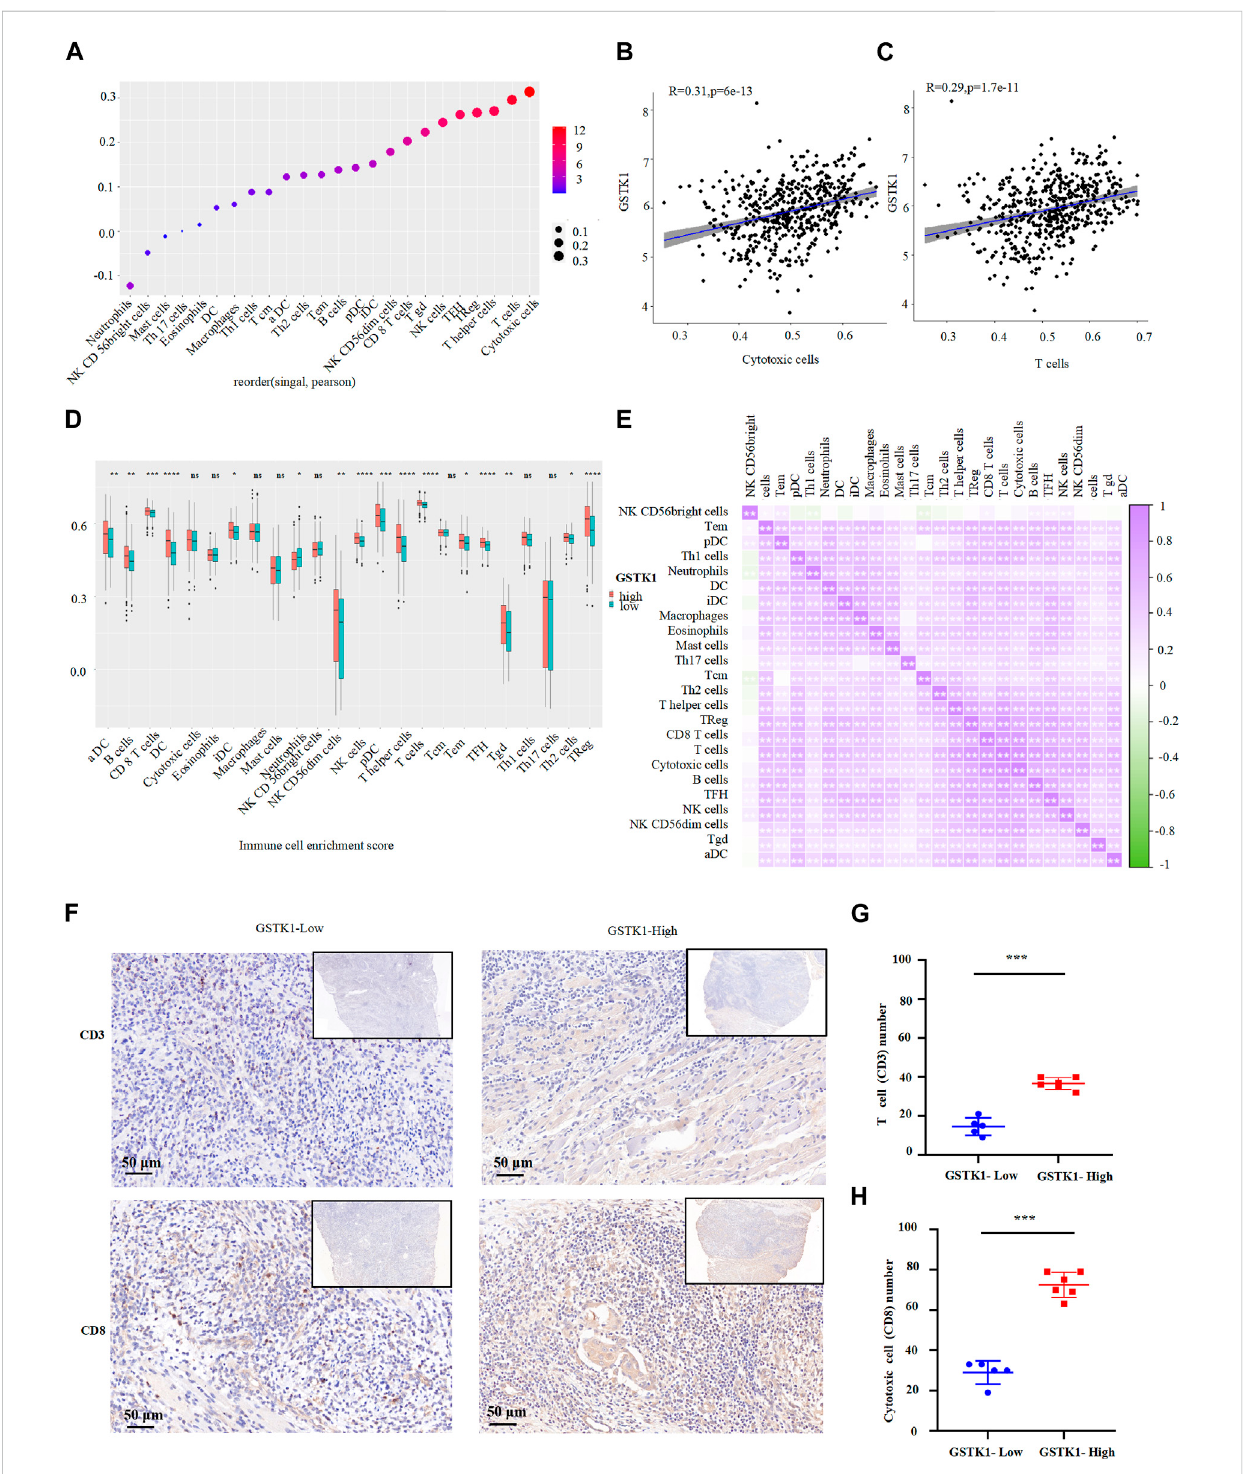
FIGURE 6 Association of GSTK1 gene expression with immune in fi ltration. (A) Association analysis between GSTK1 expression and immune cells. (B, C) AssociationanalysisbetweenGSTK1expressionandtheimmunein fi ltrationlevelsofTcellsandCytotoxiccells. (D) Thevariedproportionsof24subtypes of immune cells between low and high GSTK1 expression groups in HNSC samples. (E) Heatmap of 24 immune in fi ltration cells in tumor samples. (F) Immunohistochemical staining of CD3 and CD8 were performed in tumor tissues from GSTK1-high ( n = 6) and GSTK1-low patients groups ( n = 5). Scorebars,50 μ m. (G) ComparisonofTcell(CD3)countsinGSTK1-highandGSTK1-lowtumortissuesfromHNSCpatients. (H) ComparisonofCytotoxic cells (CD8) counts in GSTK1-high and GSTK1-low tumor tissues from HNSC patients. (* p < 0.05, ** p < 0.01, *** p <